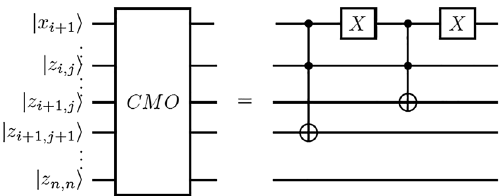
Figure 8. Quantum circuit for the CMO